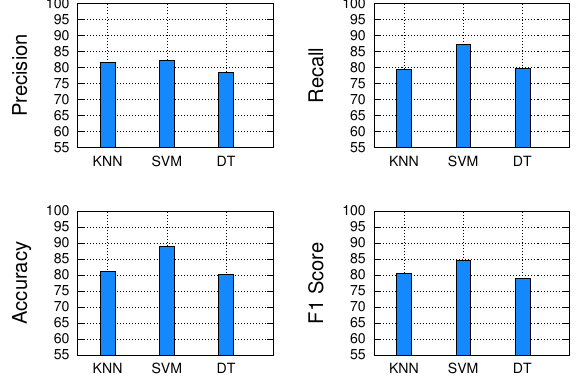
Figure 3. Performance measures for the Shadyrat malware family with network artifact classification using Chatter atop a baseline classifier